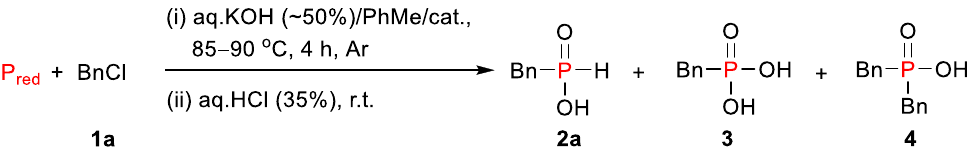
Table 1. Catalyst screening in the phosphinylation of benzyl chloride 1a with red phosphorus 1 .